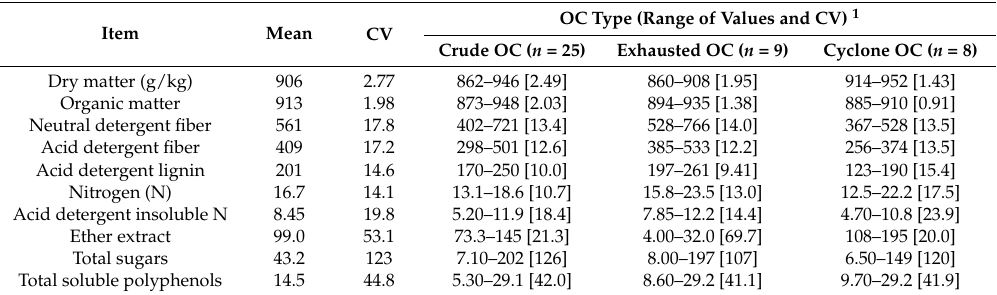
Table 1. Chemical composition (g/kg dry matter unless stated otherwise) of olive cake (OC) samples ( n = 42).